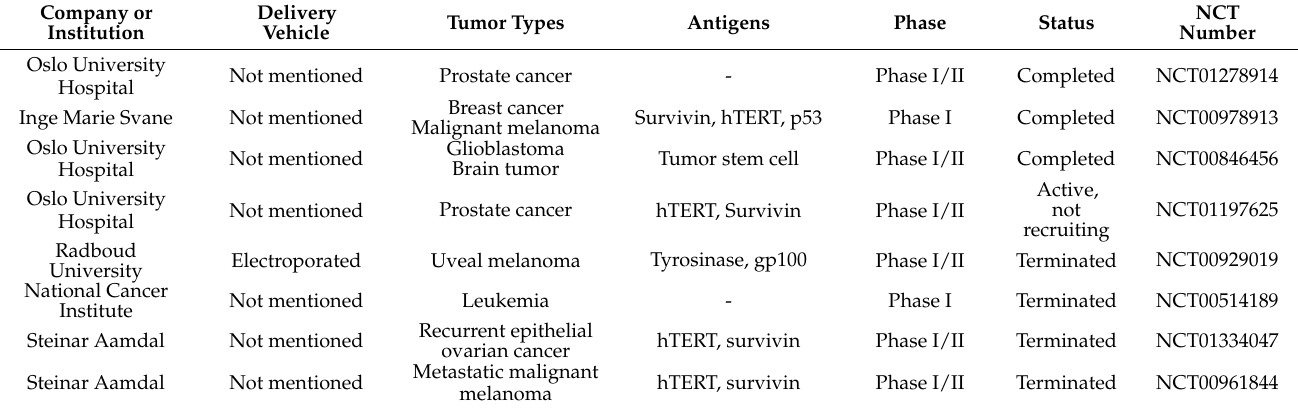
Table 3. Clinical trials of mRNA vaccine mediated by DC